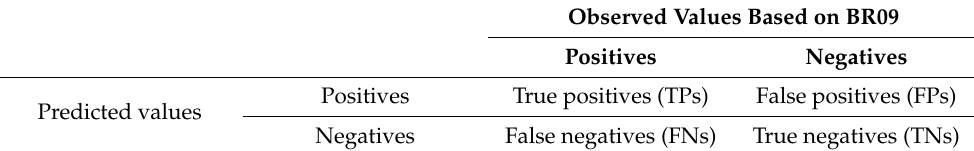
Table 3. Confusion matrix where predicted values correspond to the predicted outcome of the ML model and observed values correspond to the true underlying label of the dataset based on BR09. Positive indicates detection of the convective rain as the target rain